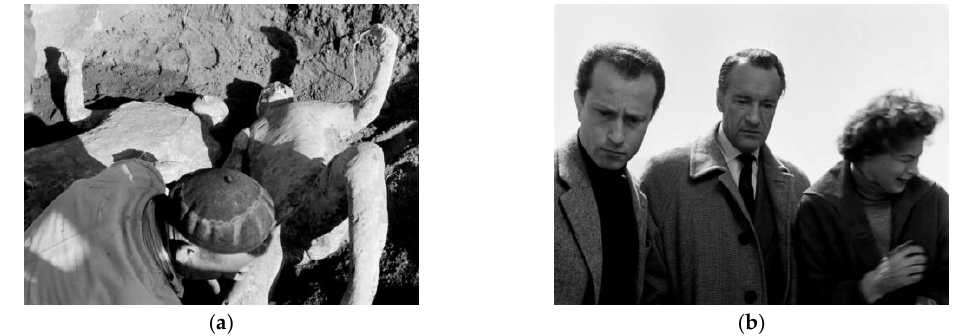
Figure 8. Frames from Journey to Italy . A revealed plaster statue representing a man and a woman who died in Pompeii ( a ), followed by a counter shot of the three characters looking at it ( b ). Source: Blu-Ray edition by The Criterion Collection (USA).